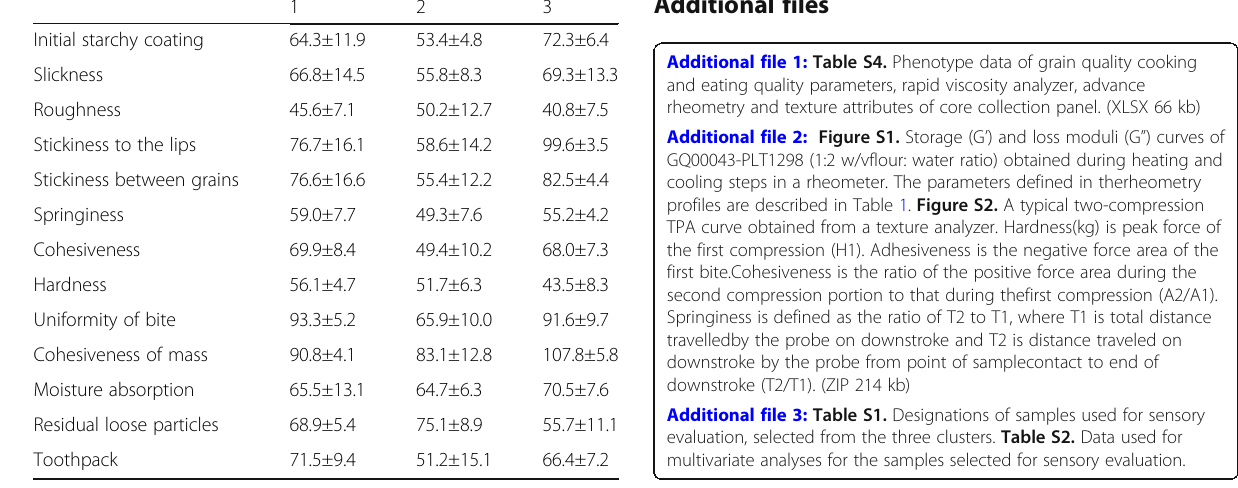
Table 7 Comparison of intensities of sensory attributes based on descriptive test conducted through panel evaluation Sensory